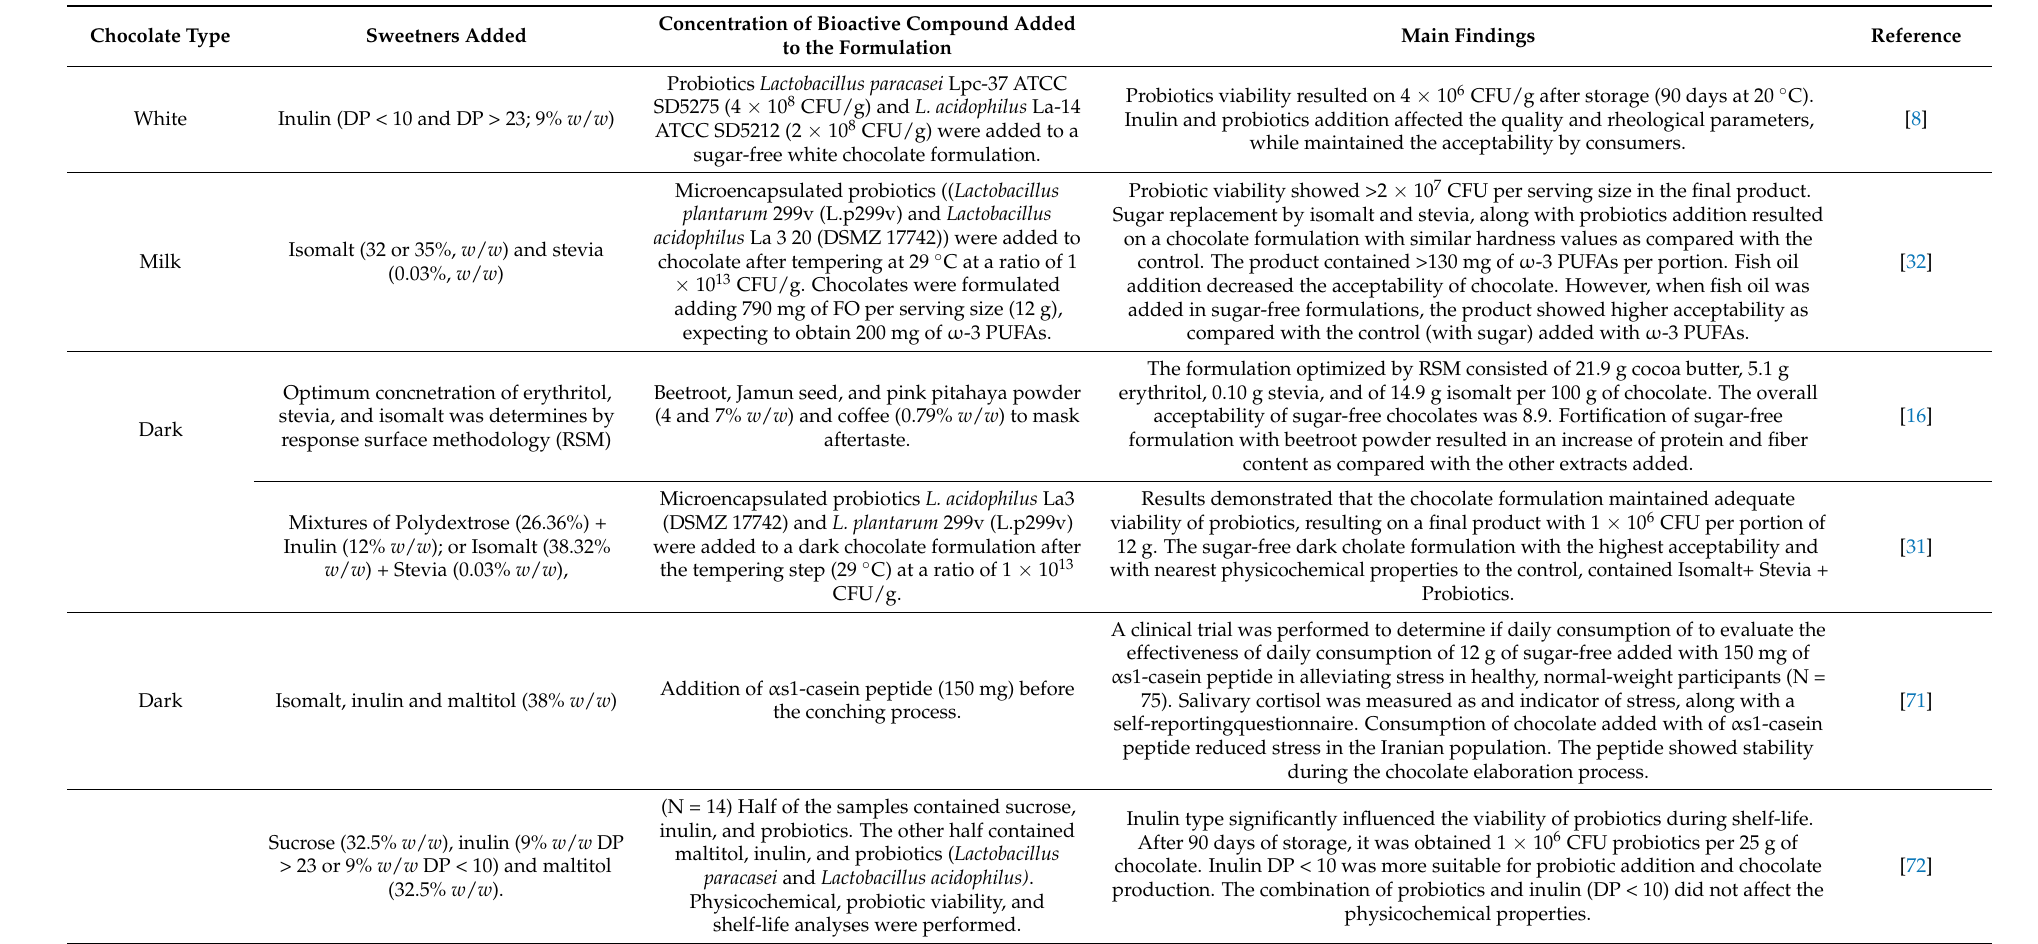
Table 2. Effect of bioactive compounds addition on the physicochemical and sensory properties of sugar-free chocolate